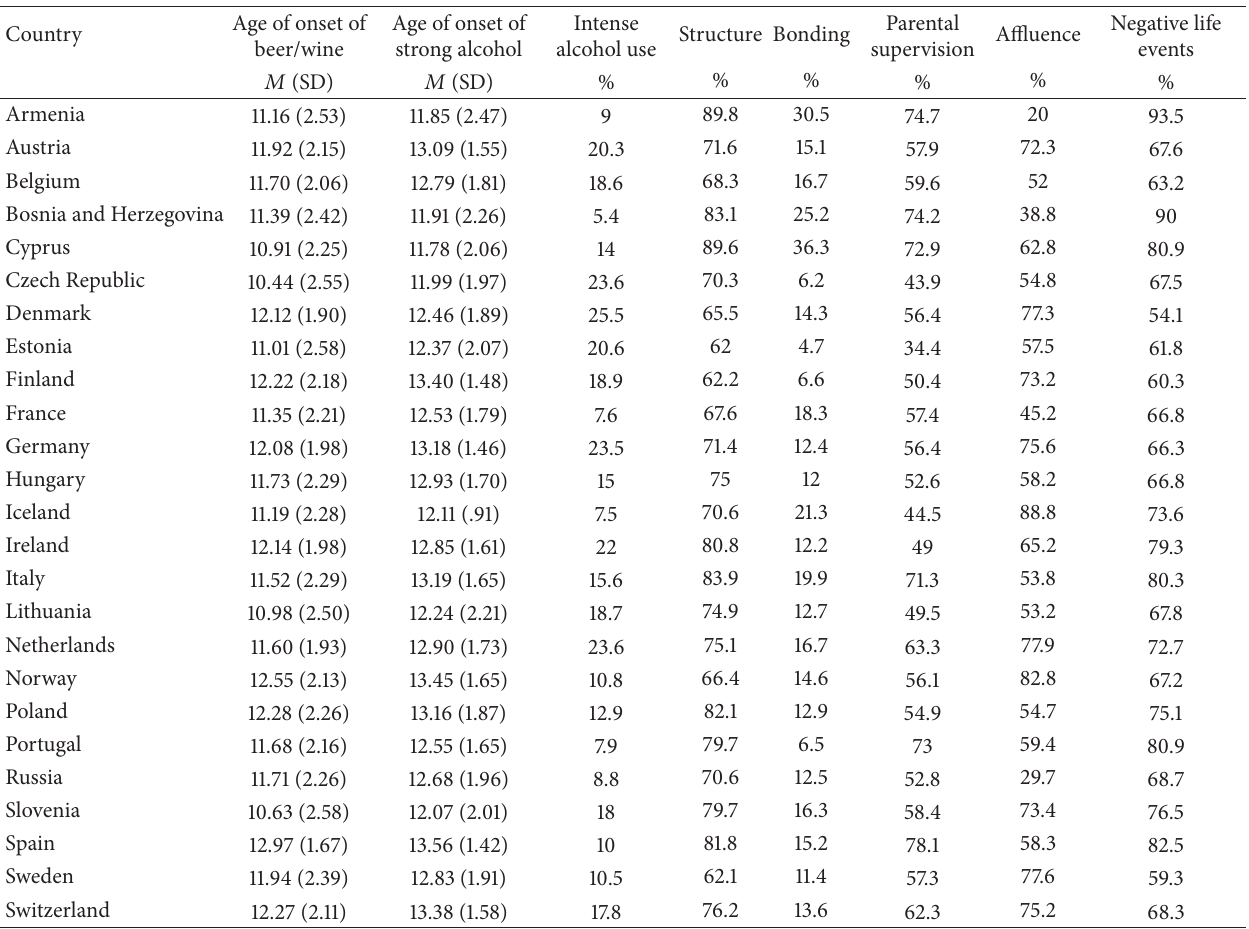
Table 1: Mean ages of onset of using alcohol and proportion of intense alcohol users and family factors in different countries (%).